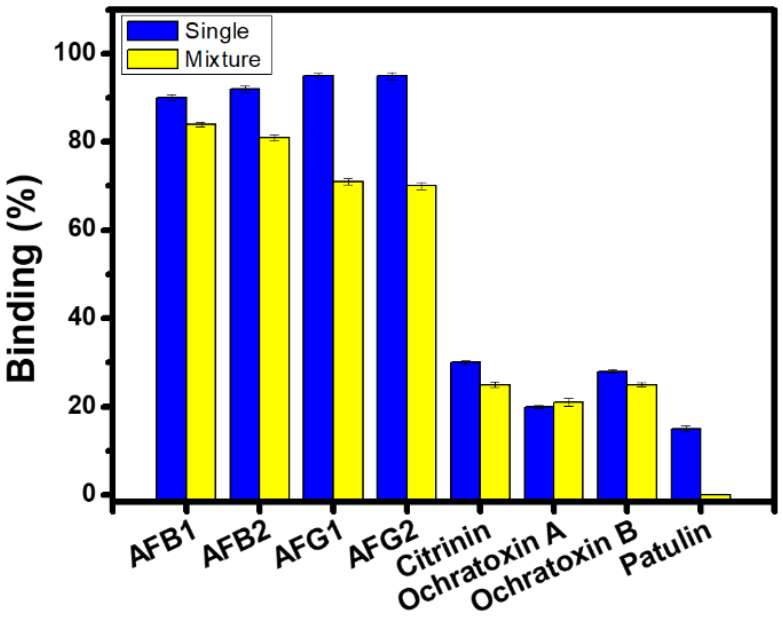
Figure 3. Selective adsorption of MIPs for single compounds in blue (AFB1, AFB2, AFG1, AFG2, Citrinin, Ochratoxin A, Ochratoxin B, and Patulin) and in a mixture, with the compounds in yellow at a concentration of 5